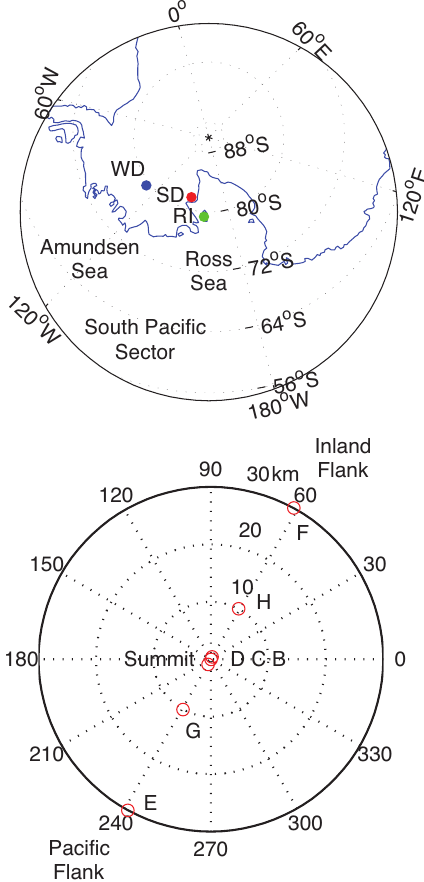
Figure 1. Top panel: map of Antarctica centered on the Ross Sea region. The red dot is Siple Dome (SD), the blue dot is the WAIS Figure 1. Top) Map of Antarctica centered on the Ross Sea region. Divide (WD), and the green dot is Roosevelt Island (RI). WD and The red dot is Siple Dome (SD), the blue dot is WAIS Divide (WD), RI are recently drilled ice cores in close proximity to Siple Dome. and the green dot is Roosevelt Island (RI). WD and RI are recently Bottom panel: local map of Siple Dome including grid locations of drilled ice cores in close proximity to Siple Dome. Bottom) Local shallow ice cores B–H. The Pacific flank cores are to the north of map of Siple Dome including grid locations of shallow ice cores B-H. The Pacific Flank cores are to the North of the Dome Summit, the dome summit, and the inland flank cores are to the south of the and the Inland Flank cores are to the South of the Dome Summit. dome summit.